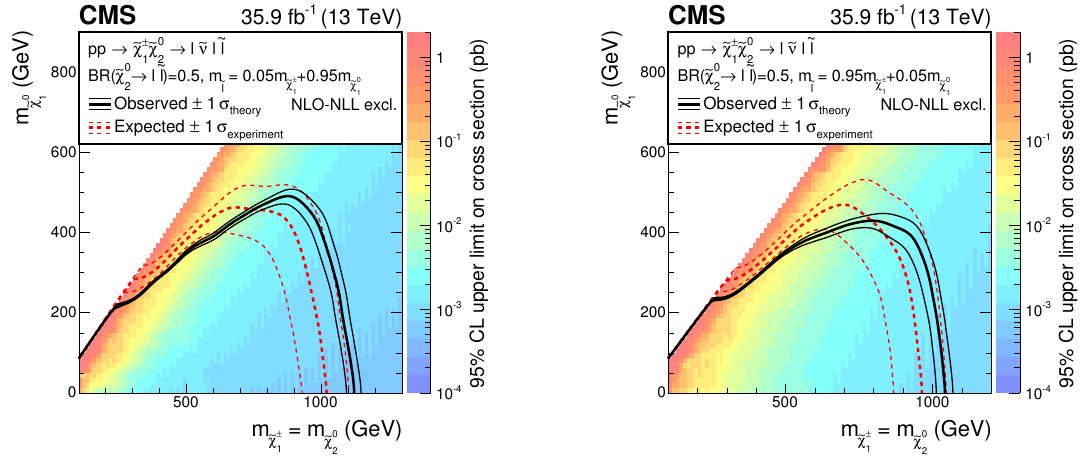
Figure 15 . Interpretation of the results in the (cid:13)avor-democratic model with mass parameter x = 0 : 05 (left) and x = 0 : 95 (right) obtained with the combination of the SS dilepton category and category A. The shading in this (cid:12)gure is as described in (cid:12)gure